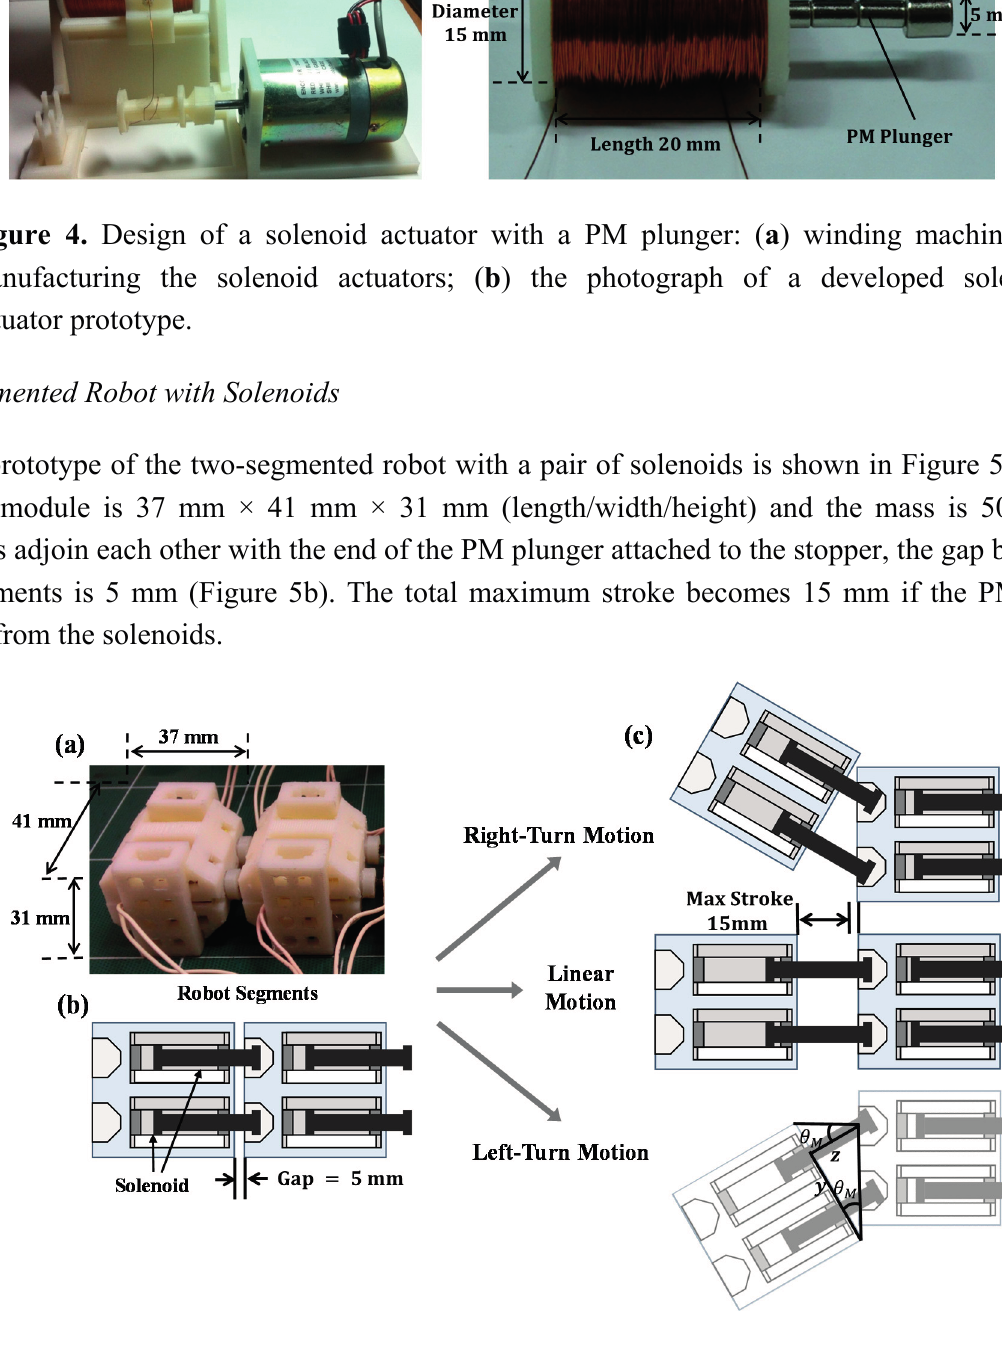
Figure 5. ( a ) Prototype of a two-segmented robot; ( b ) two segments adjoin each other; ( c ) the linear and turning motions of the segmented robot by symmetrical and